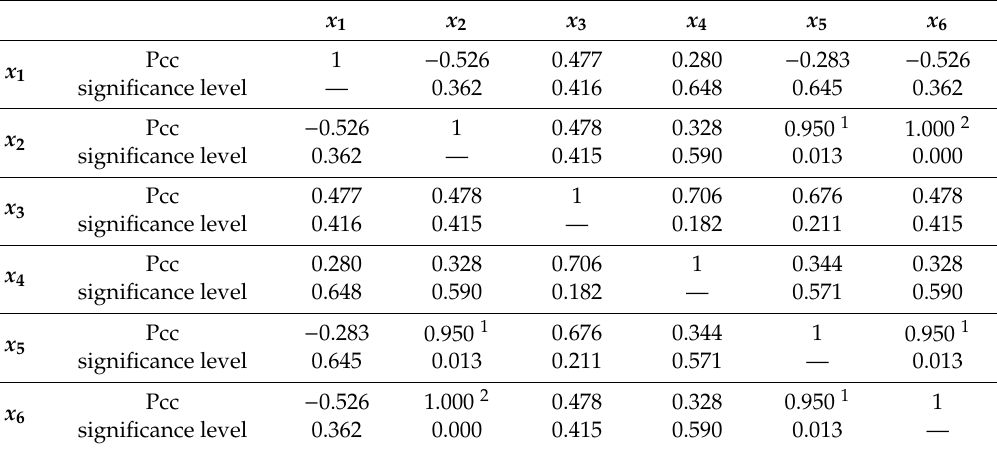
Table 4. Pearson correlation analysis of measured